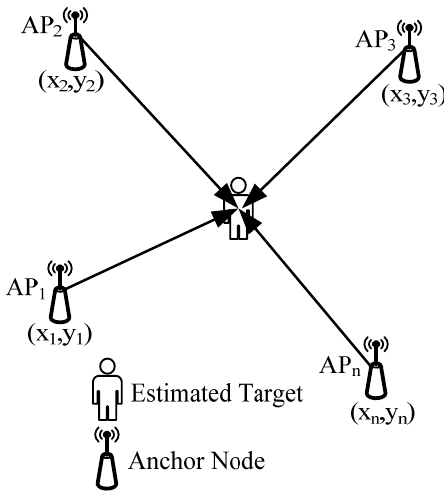
19 of 45 Figure 10. Min–max ‐ based positioning method. The bounding box of anchor a is created by adding and subtracting the estimated distance